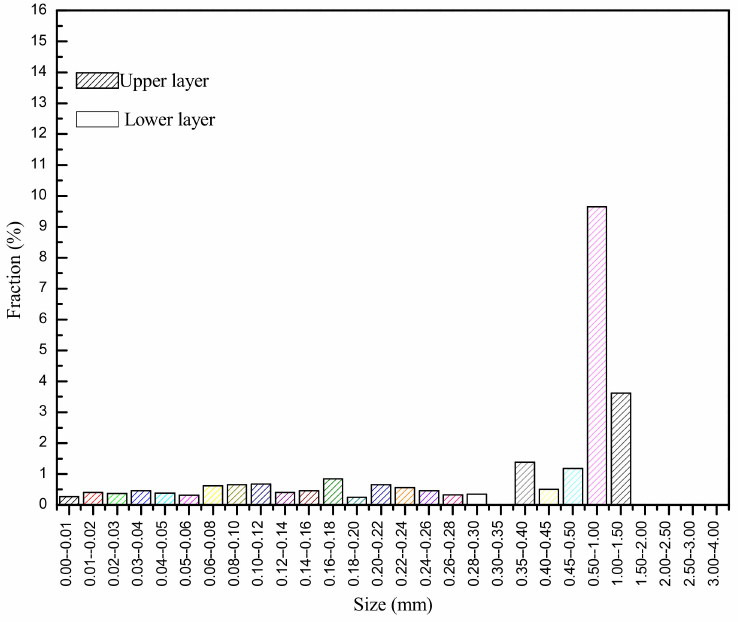
Figure 2. Pore size distributions of the upper and lower layers.